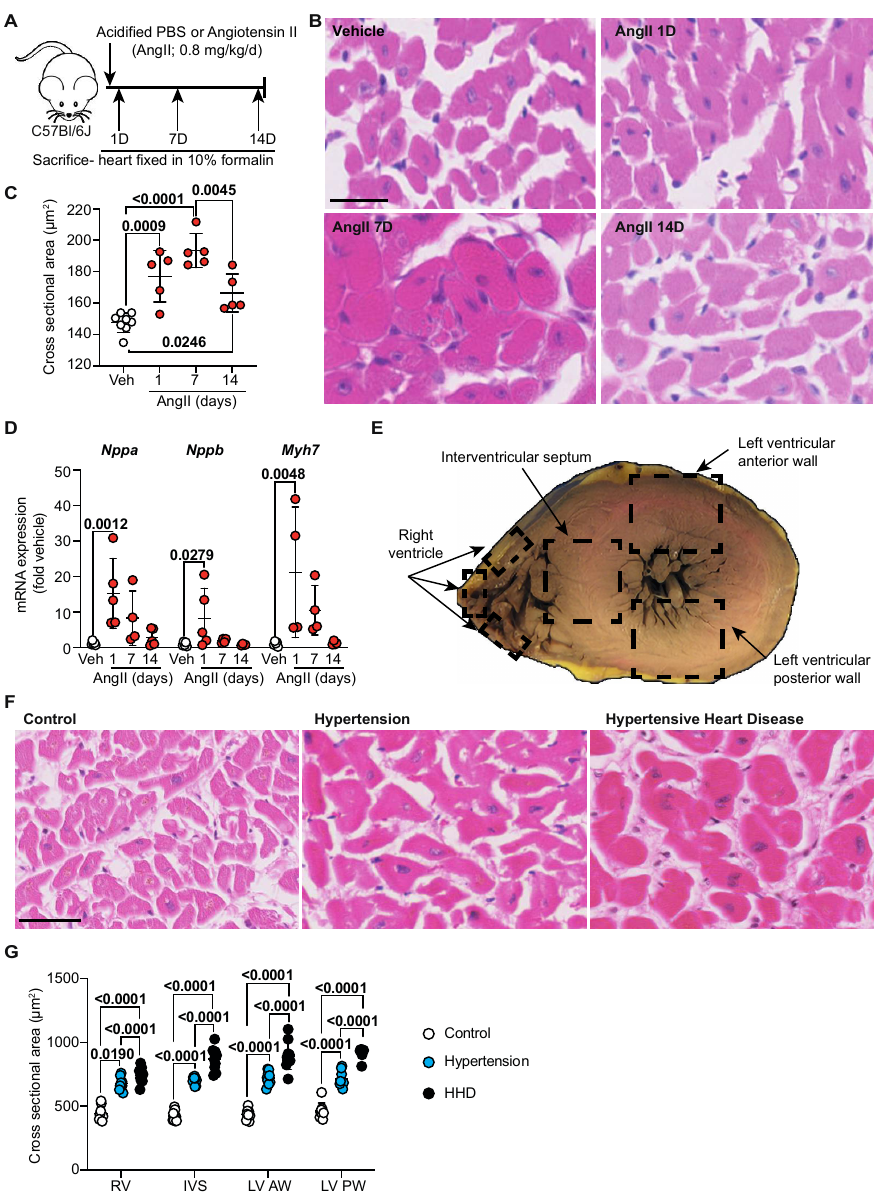
Figure 1. Cardiomyocyte hypertrophy is an acute phase in hypertension. ( A ) Schematic of hypertensive murine model. C57Bl/6J wild-type mice treated with either vehicle (Acidified PBS; n = 10) or Angiotensin II (AngII; 0.8 mg/kg/day) for 1 d, 7 d or 14 d ( n = 4–5/group). ( B ) Representative images of murine heart sections stained with haematoxylin and eosin (H&E). Line represents 25 µm. ( C ) Quantification of murine cardiomyocyte cross-sectional area. Data are individual points with means ± SD. Stats: 1-way ANOVA with Holm–Sidak post-test. ( D ) Mouse cardiac RNA was isolated and mRNA expression of hypertrophy-associated genes determined by quantitative polymerase chain reaction. Data are individual points with means ± SD. Stats: 1-way ANOVA with Holm–Sidak post-test. ( E ) Schematic indicating regions of the human heart from which sections were taken for analysis. ( F ) Representative images of human left ventricular anterior wall stained with H&E. Line represents 50 µm. ( G ) Quantification of cross-sectional area of cardiomyocytes (control, n = 10; hypertension, n = 9; hypertensive heart disease, n = 10) across the whole human heart. Data are individual points with means ± SD. Stats: 1-way ANOVA with Holm–Sidak post-test. RV—right ventricle; IVS—interventricular septum; LV—left ventricle; AW—anterior wall; PW—posterior wall.